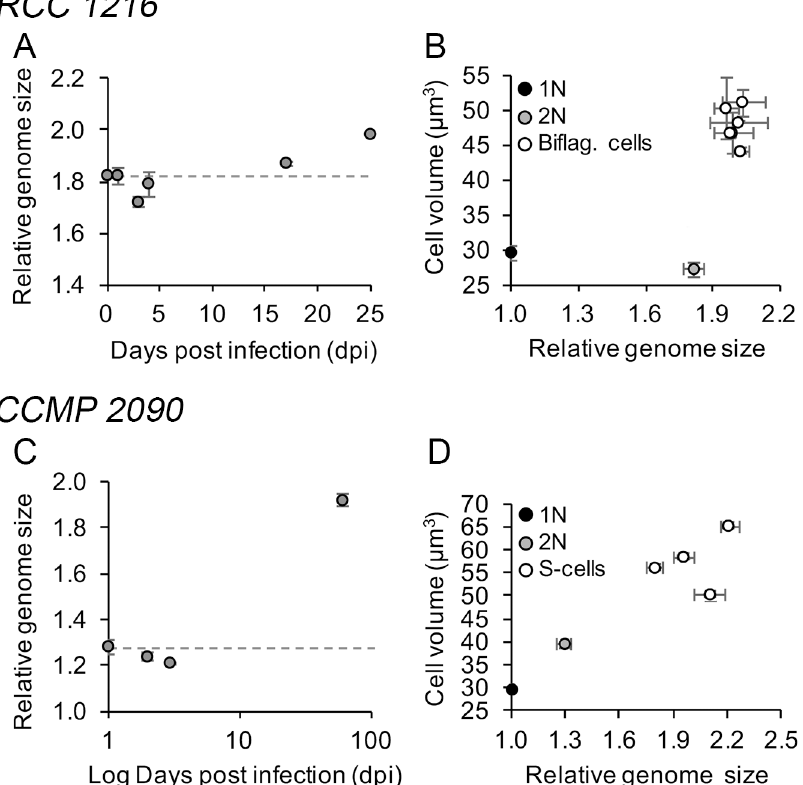
Fig 3. Genome-size analysis of E . huxleyi cells during EhV infection and recovery. Genome-size analysisrepresents the cells’ DNA content as measuredby the stainingintensity of isolatednuclei in the G1 phasewith the fluorescentprobe SYBR-Green and assessed by flow cytometry (see methods). (A) Temporal variation of the averagerelativegenome size of cells duringEhV infection. (B) Relativegenomesize and cellularbiovolume( μ m 3 ) of RCC 1216 (2N) and five representativebiflagellate clones postinfection. We note that the cell biovolumeof RCC 1216 was determined with cells treated with 1 μ M EDTA to dissolvecoccoliths and provideprecise measurements of actual cell size. (C,D) as in (A,B) but using noncalcified E . huxleyi strain CCMP 2090, 2N. All of the data presented for relative genomesize were normalized to the haploid(1N) genomeof strain RCC 1217. The mean ± standard deviationof duplicatecultures is